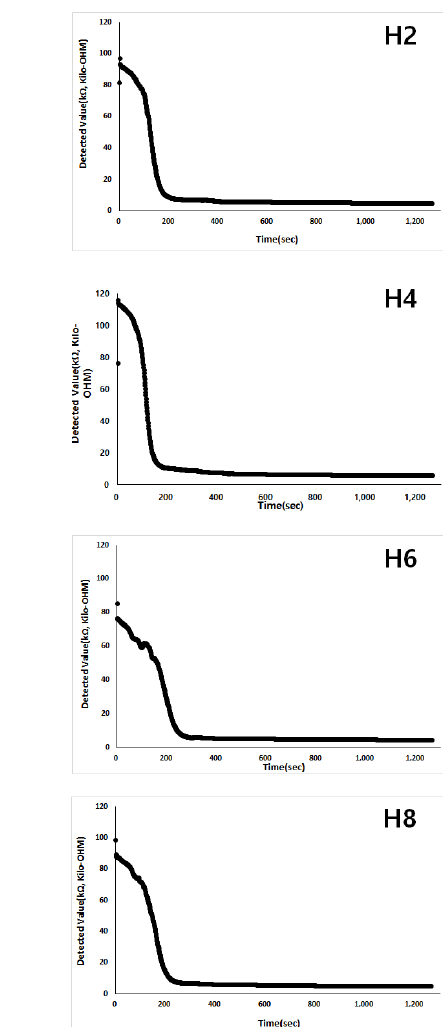
Figure 6. Measurement of the bioreactor sludge by the sludge sedimentation measuring sensor.